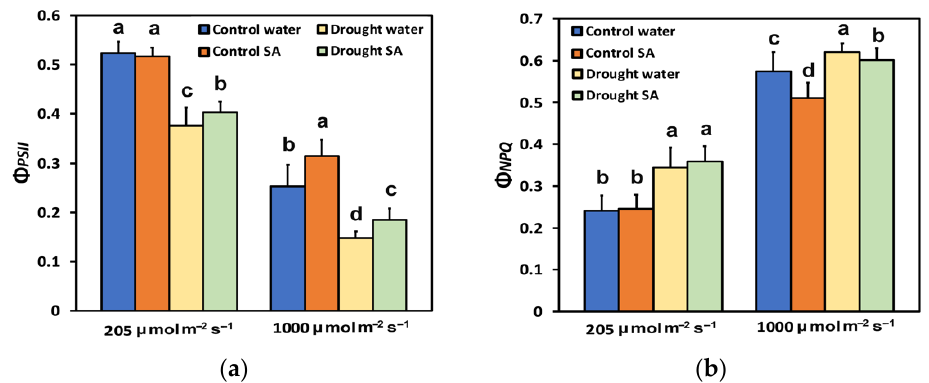
Figure 2. The effective quantum yield of PSII photochemistry ( Φ PSII ) ( a ); and the quantum yield of regulated non-photochemical energy loss in PSII ( Φ NPQ ) ( b ); of oregano seedlings grown under optimal conditions (control) or moderate drought stress (MoDS), and sprayed by 1 mM SA or H 2 O. Φ PSII and Φ NPQ were estimated at 205 (LL) or 1000 (HL) μ mol photons m –2 s –1 . Error bars represent standard deviations ( n = 4). Different lowercase letters, within the same light treatment, represent statistical difference ( p < 0.05).